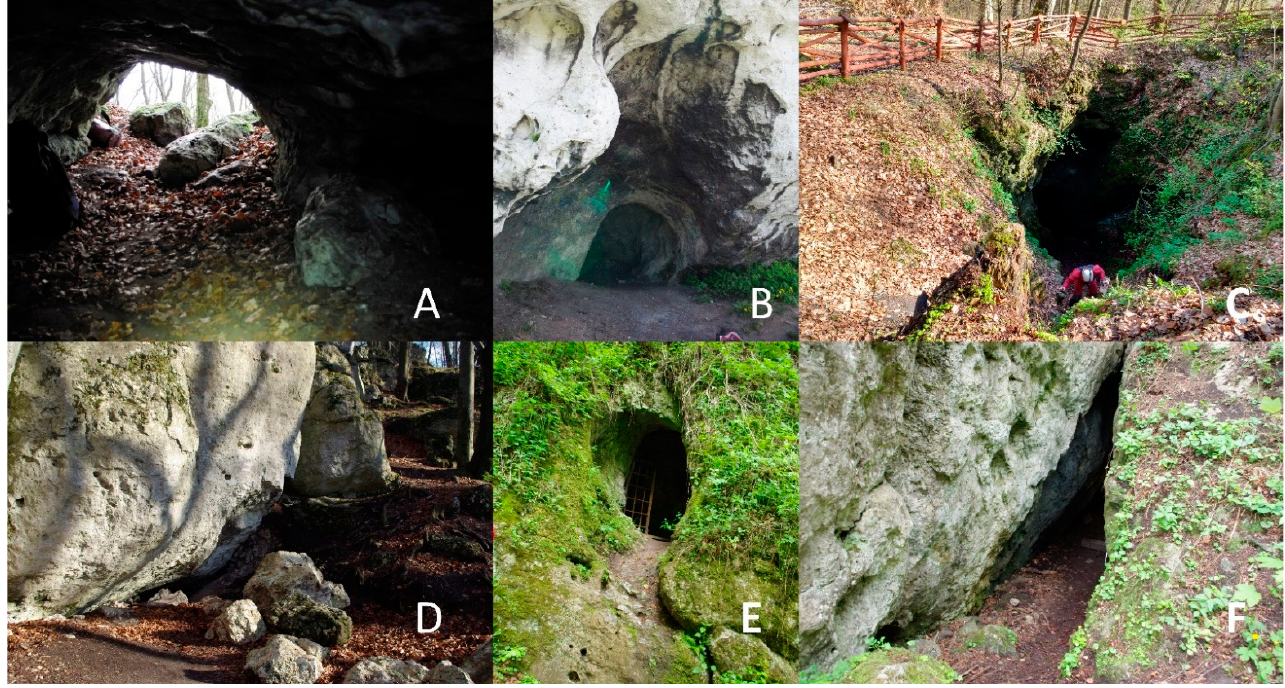
Figure 2. Entrances of studied caves. ( A )—W Zielonej Górze cave; ( B )—Towarna cave; ( C )—Pod Sokol ą cave; ( D )—Kroczycka cave; ( E )—Psia cave; ( F )—Zegar cave.